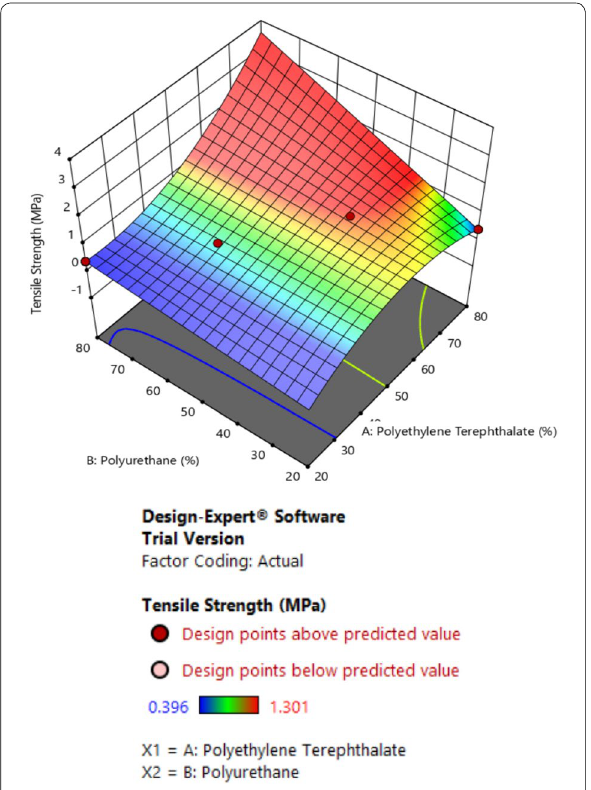
Fig. 7 3D surface plot (tensile